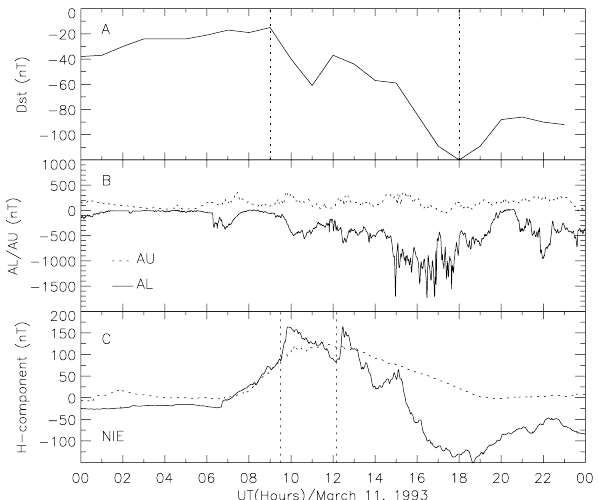
Fig. 1. Variation of the Dst index (A) , the auroral indices AL and AU (B) and the geomagnetic H-component (C) on 11 March 1993 (solid line). The dotted line (C) shows the quiet time variation ( S r (H) ) on 5 March 1993 (reference quiet days).